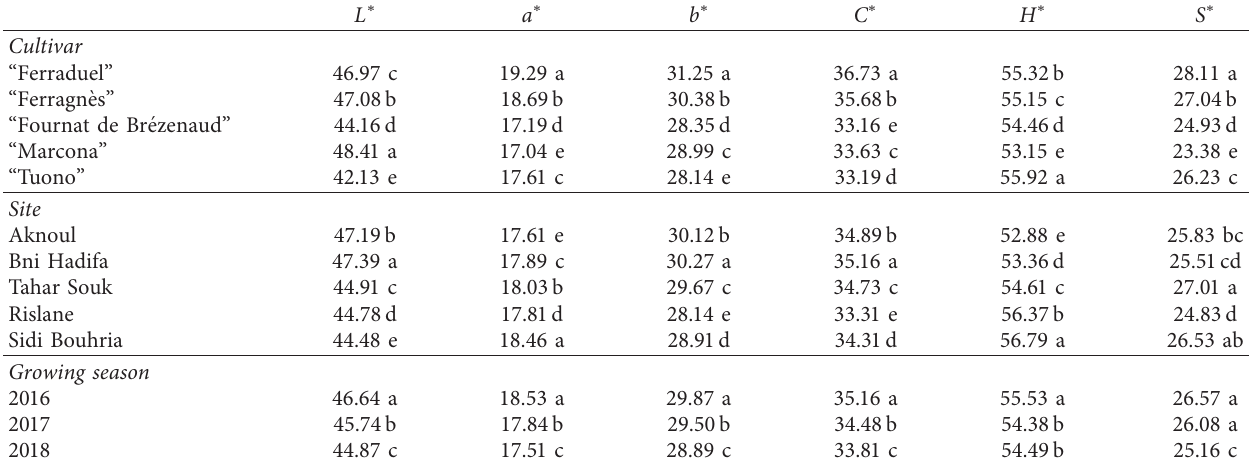
Table 2: Mean values of cultivars, sites, and growing seasons for brightness index ( L ∗ ), redness index ( a ∗ ), yellowness index ( b ∗ ), chroma ( C ∗ ), hue angle ( H ∗ ), and metric saturation ( S ∗ ) of five almond cultivars grown in different sites of north-eastern Morocco (Aknoul, Bni Hadifa, Tahar Souk, Rislane, and Sidi Bouhria) during three growing seasons (2016 − 2018). Means for each character followed by the same letter are not significantly different at P < 0 .